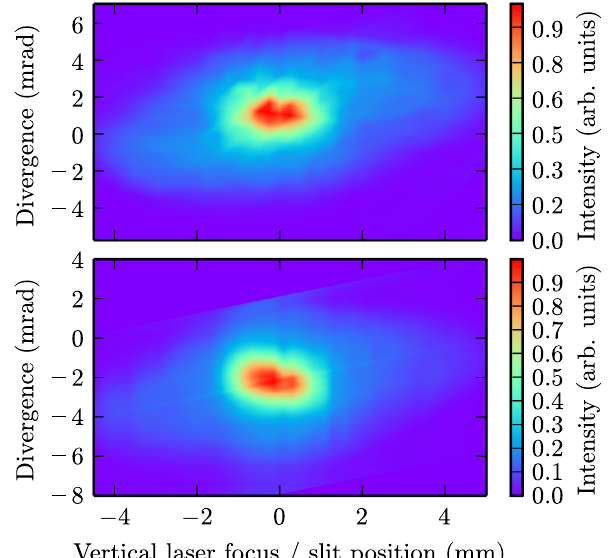
FIG. 12. Vertical transverse phase-space of the 3 MeV H − beam measured by laserwire (top) and slit and grid method (bottom).